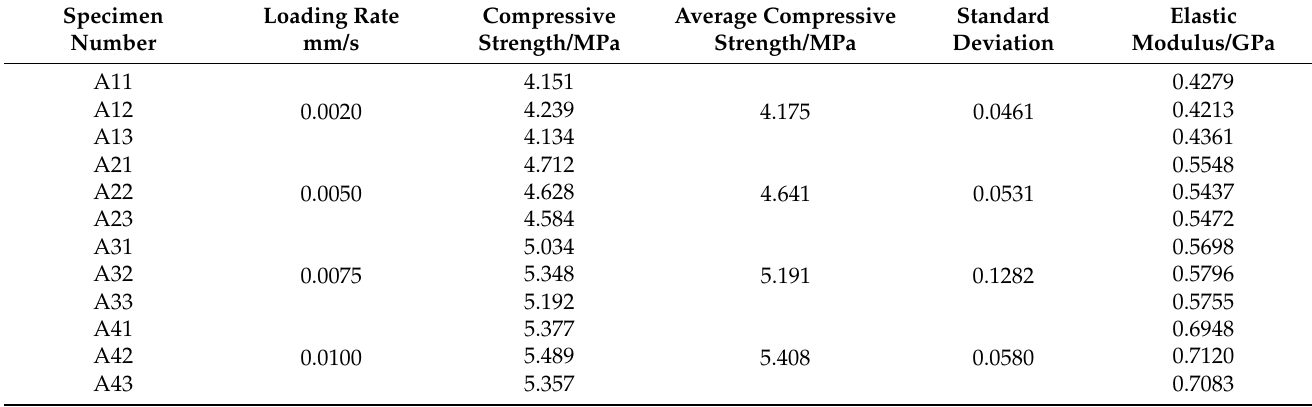
Table 4. UCS of the ASPM specimens with different loading rates.